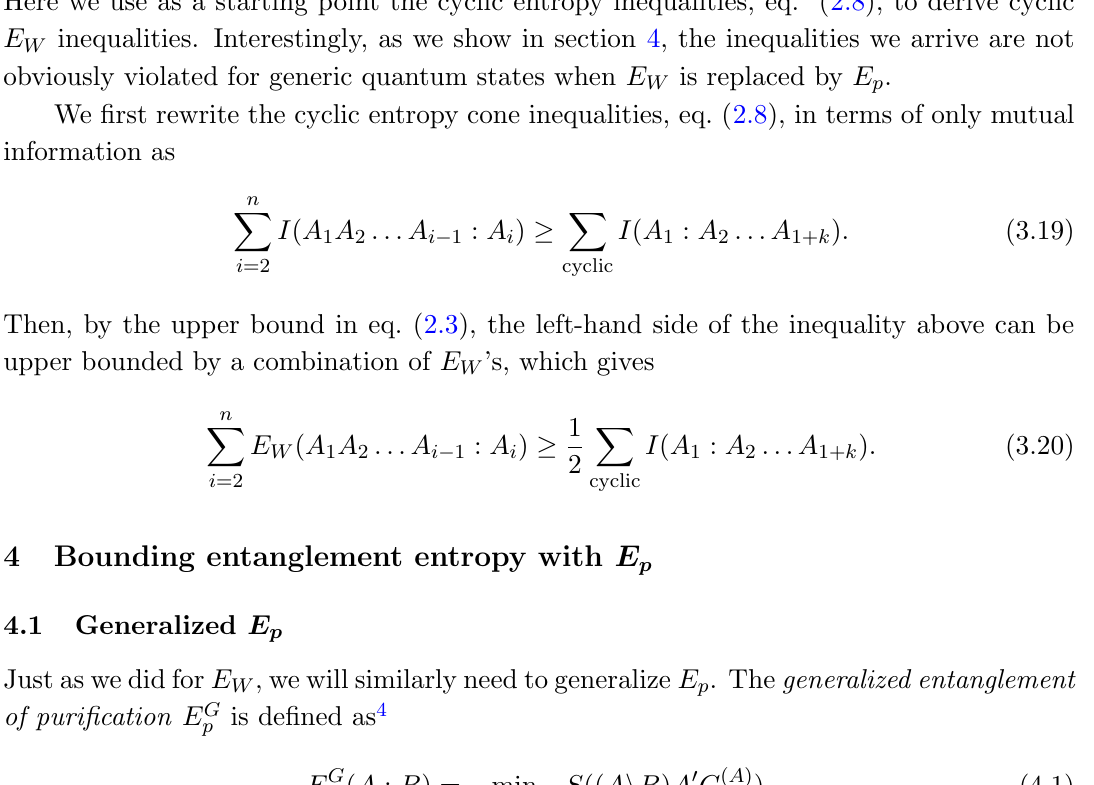
Figure 3 . As depicted, for the optimal choices of A 0 ; B 0 and C ( A ) ; we have E G S (( A n B ) A 0 C ( A ) )